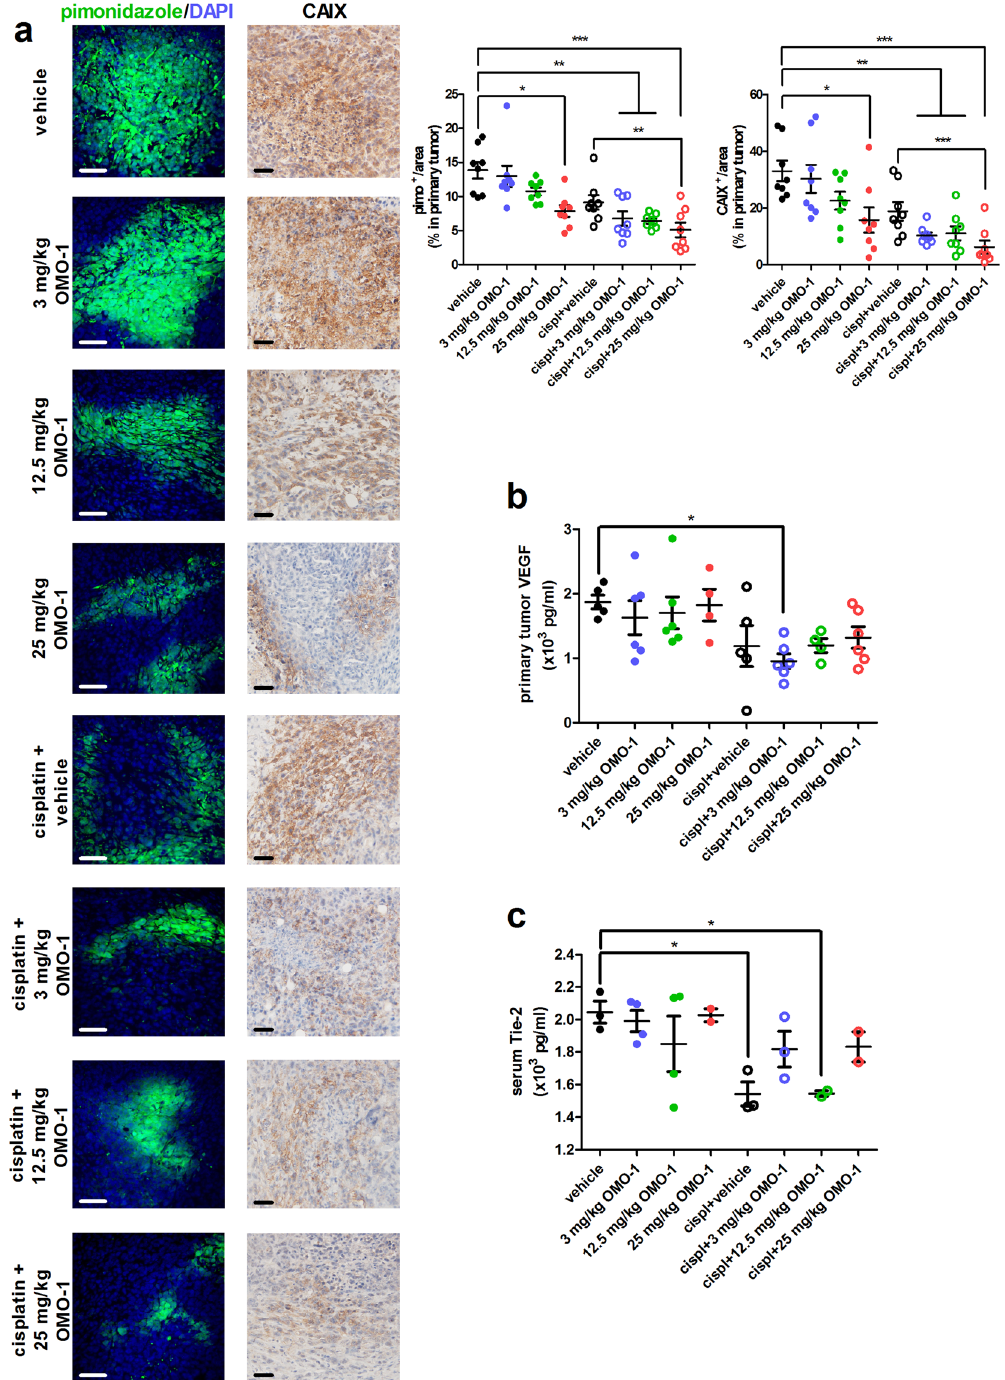
Fig. 3 OMO-1 treatment reduces tumor hypoxia without affecting vascular formation in a 4T1-based intraductal model. a Immunohistochemistry for the hypoxia markers pimonidazole and CAIX on paraf fi n sections of primary tumors from the different treatment groups at 39 days p.i. ( n = 8; 2 slides per treatment group for each marker with 4 images per slide). Pimonidazole adducts are identi fi ed through FITC fl uorescence and DAPI identi fi es cellular nuclei through blue fl uorescence. Scale bars = 50 µm. b VEGF levels in primary tumors from the different treatment groups at 39 days p.i. ( n = 5 for vehicle and cisplatin + vehicle, n = 4 for 25 mg/kg OMO-1 and cisplatin + 12.5 mg/kg OMO-1, n = 6 for all other treatment groups). c Tie-2 levels in serum from the different treatment groups at 39 days p.i. ( n = 3 for vehicle, cisplatin + vehicle and cisplatin + 3 mg/kg OMO-1, n = 2 for 25 mg/kg OMO-1, cisplatin + 12.5 mg/kg OMO-1, and cisplatin + 25 mg/kg OMO-1, n = 4 for all other treatment groups). Data are presented as the means ± SEM. * P < 0.05, ** P < 0.01, *** P < 0.001.